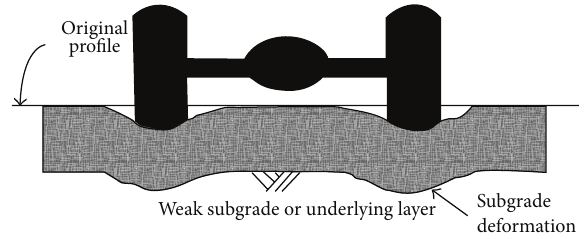
Figure 13: Consolidations rutting of flexible pavement [101].